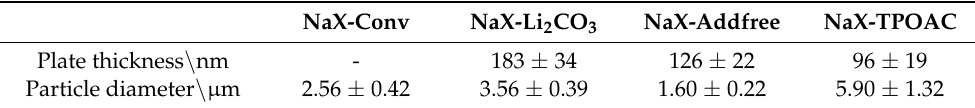
Table 2. Average plate thickness and particle diameter from SEM images of around 50 plates and particles. The variance of the values is also